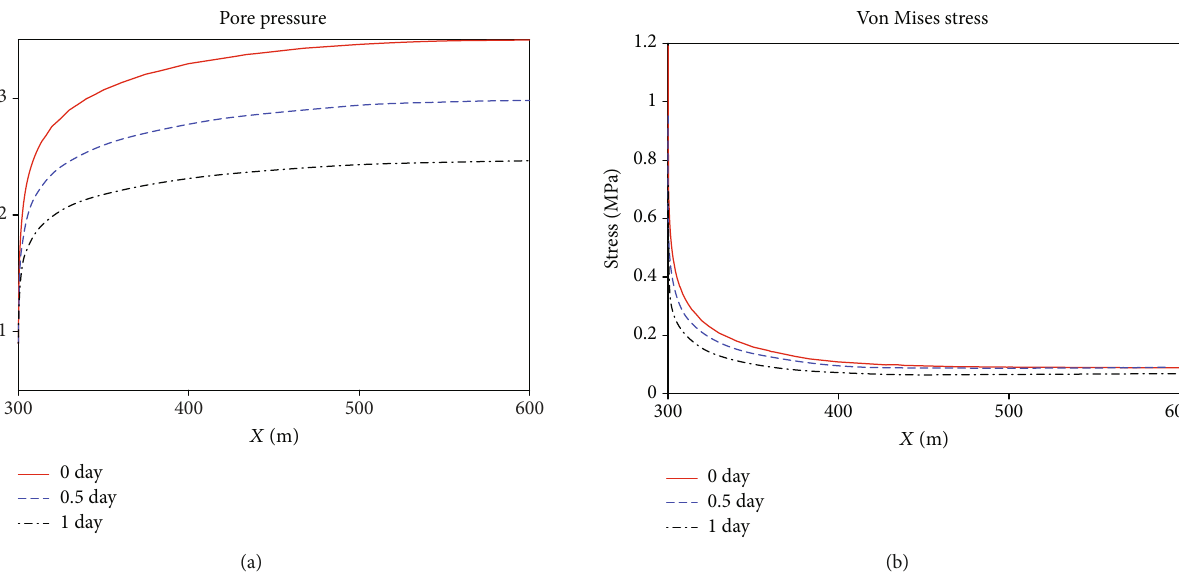
Figure 5: 1D distribution from the wellbore to the boundary of the domain for (a) pressure and (b) von Mises stress; plots for data along Y = 300m